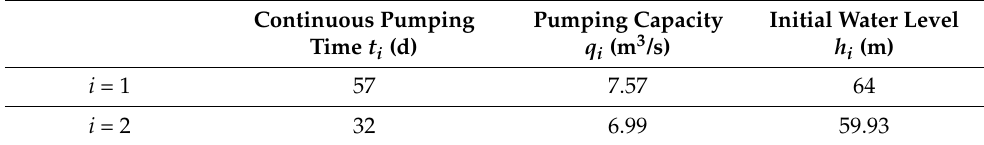
Table 7. Optimization scheme of single well pumping.